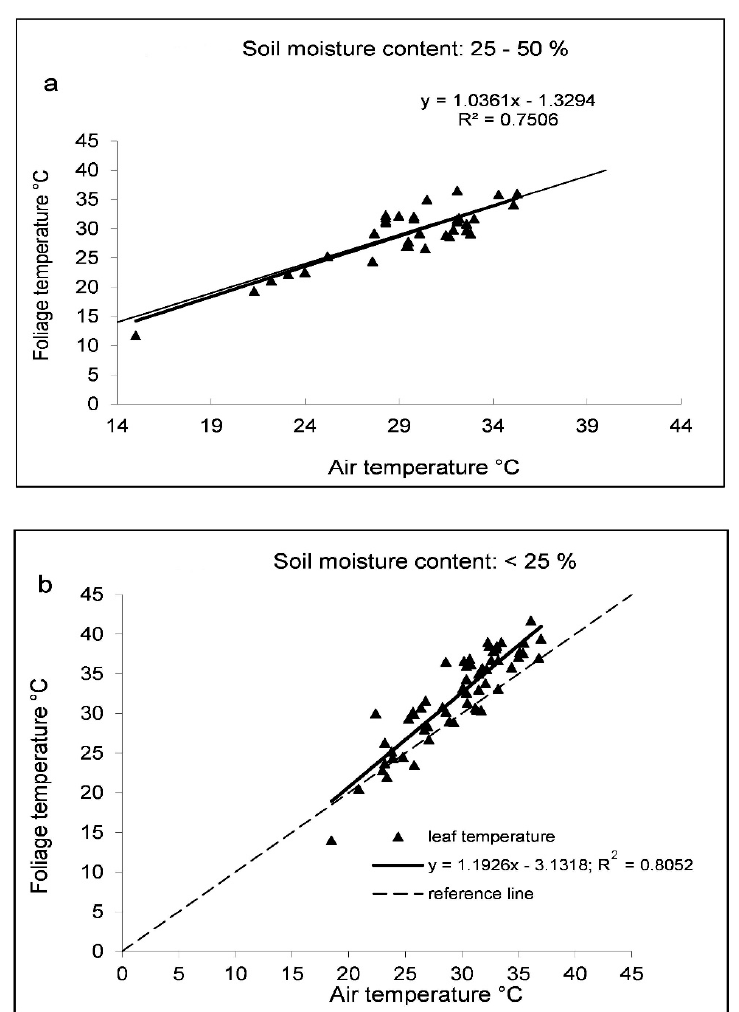
Figure 2. Relationship between air and canopy temperature for snap beans under water deficit ( a ) and severe water stress ( b ). The thick line shows the increase in leaf temperature compared to air temperature (broken line) Source: Helyes et al. [ 93 ].